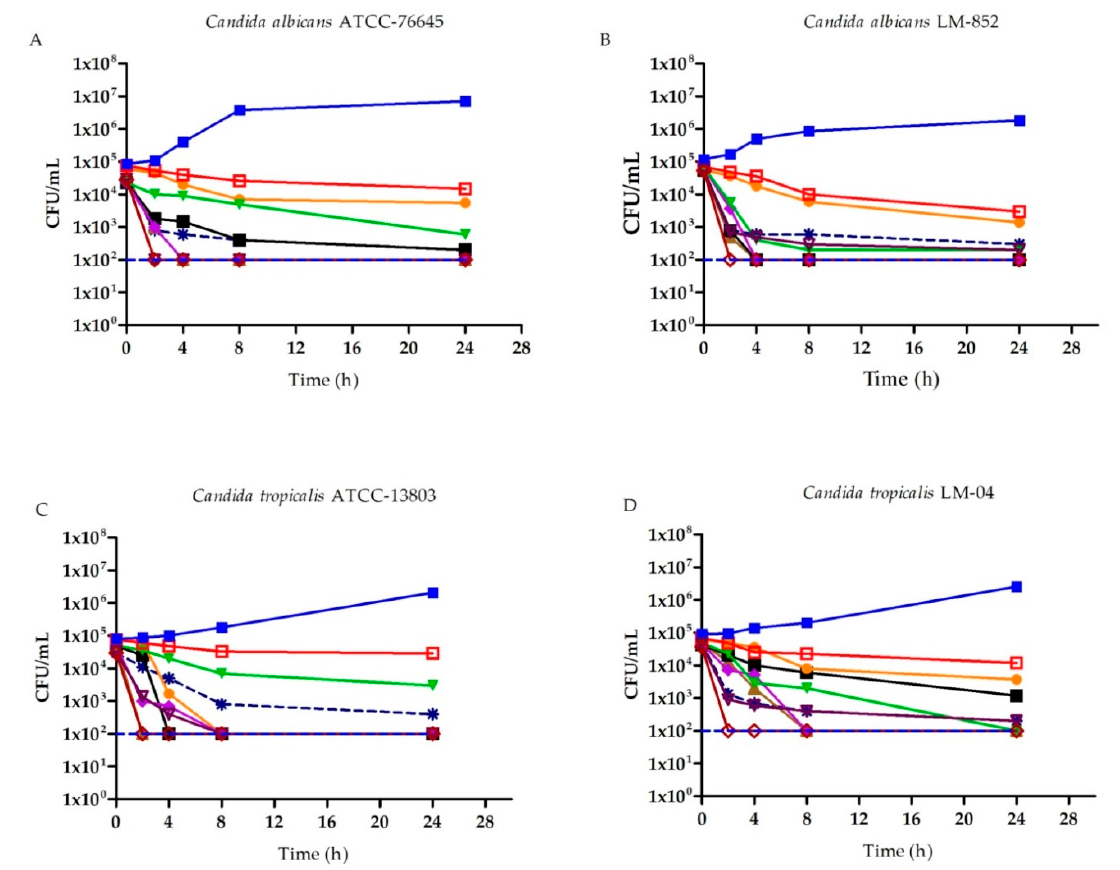
Figure 1. Microbial death curve (Log 10 CFU/mL) for strains of C. albicans and C. tropicalis, under different concentrations (MIC, MICx2, MICx4) of AB, (R)-(+)- β -citronellol, and (S)-( − )- β -citronellol in different time intervals. (A) Microbial death curve for C. albicans ATCC 76645. (B) Microbial death curve for C. albicans LM-852. (C) Microbial death curve for C. tropicalis ATCC 13803. (D) Microbial death curve for C. tropicalis LM-04. ( ) Control of viability for strains ( C. albicans ATCC